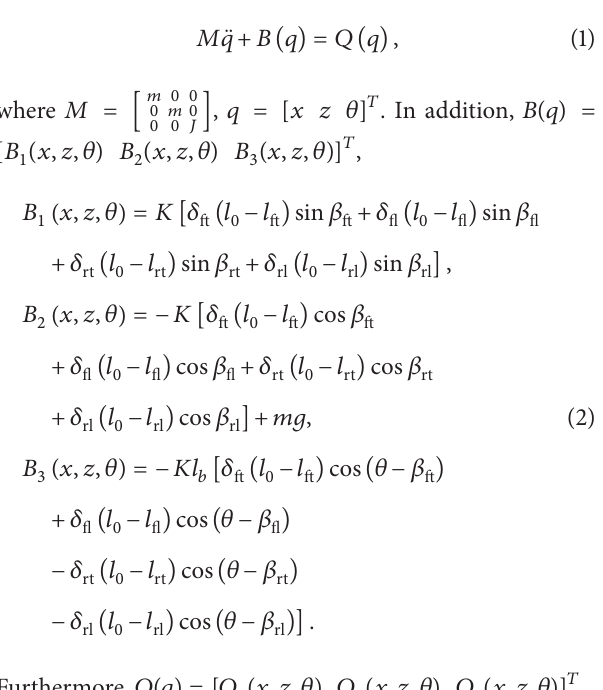
leg, and rear trailing leg) are indicted as fl, ft, rl, and rt, respectively. Furthermore, based on the energy conservation and the Lagrange equations, the dynamic model of the BSL system is constructed when the damping energy dissipation terms are